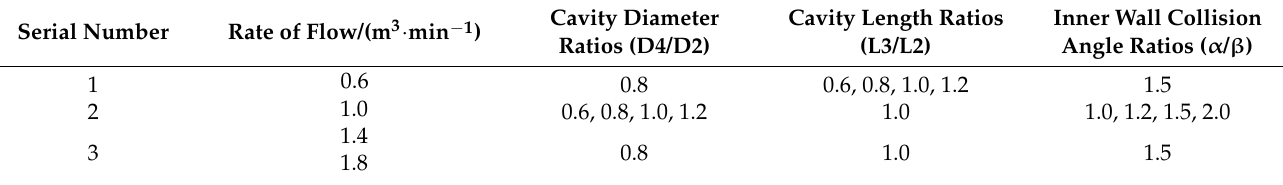
Table 2. The test parameters of the multi − source pulsed jet